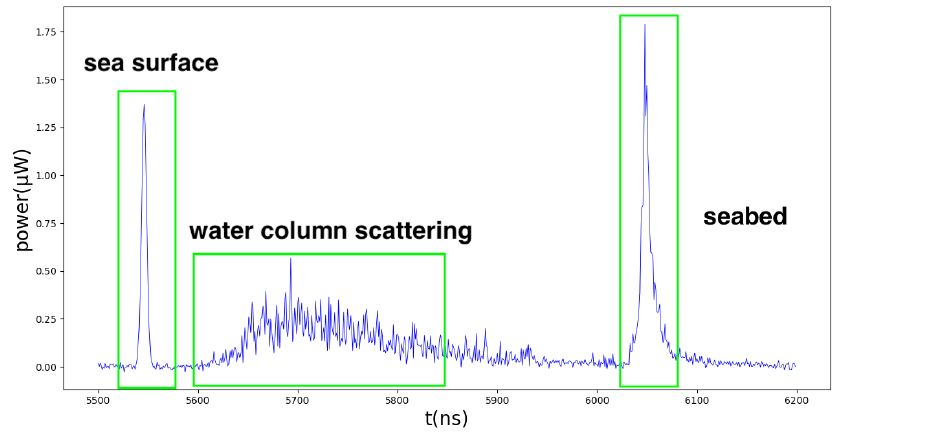
Figure 2. Schematic diagram of bathymetry data.